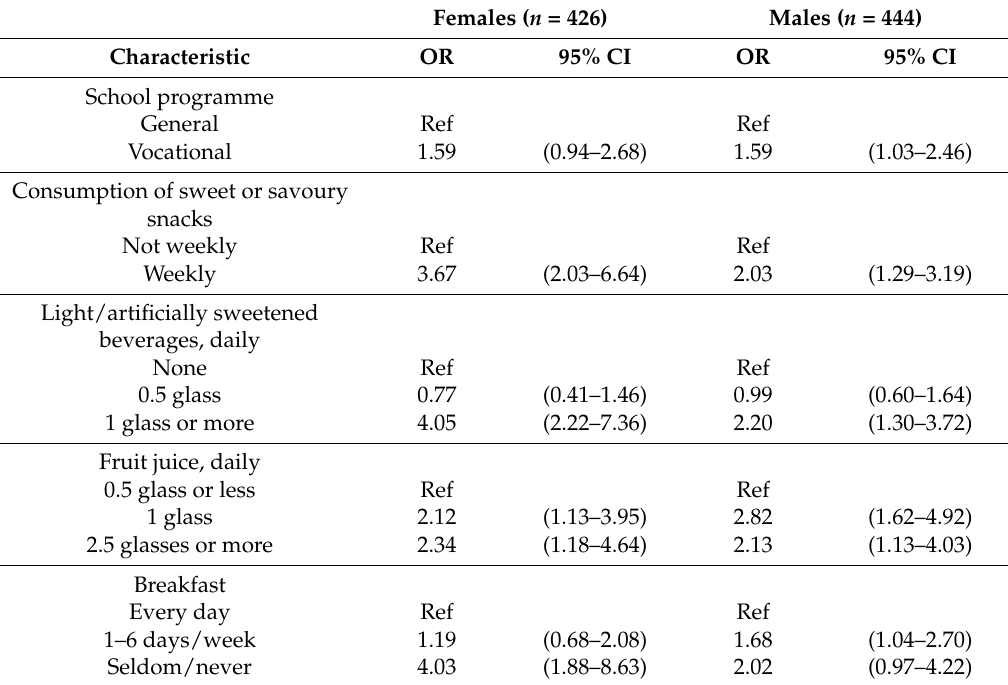
Table 3. Characteristics Associated with being a daily drinker of sugar-sweetened beverages in the Tromsø study: Fit Futures